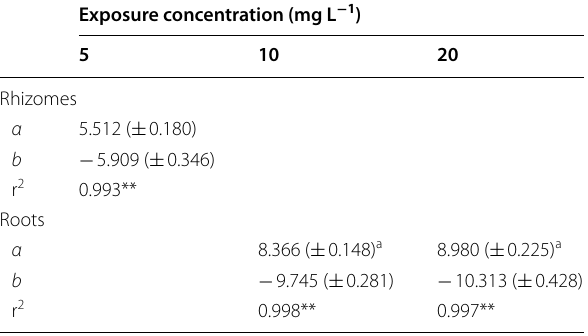
The exposure concentrations of 5, 10 and 20 mg L − 1 correspond to 44.48, 88.95 and 177.94 μM, respectively The fits correspond to an S equation: lnC C, tissue concentration (μg g − 1 dry wt) reached in a given time; α and b constants; t , time (in days); standard errors are given in